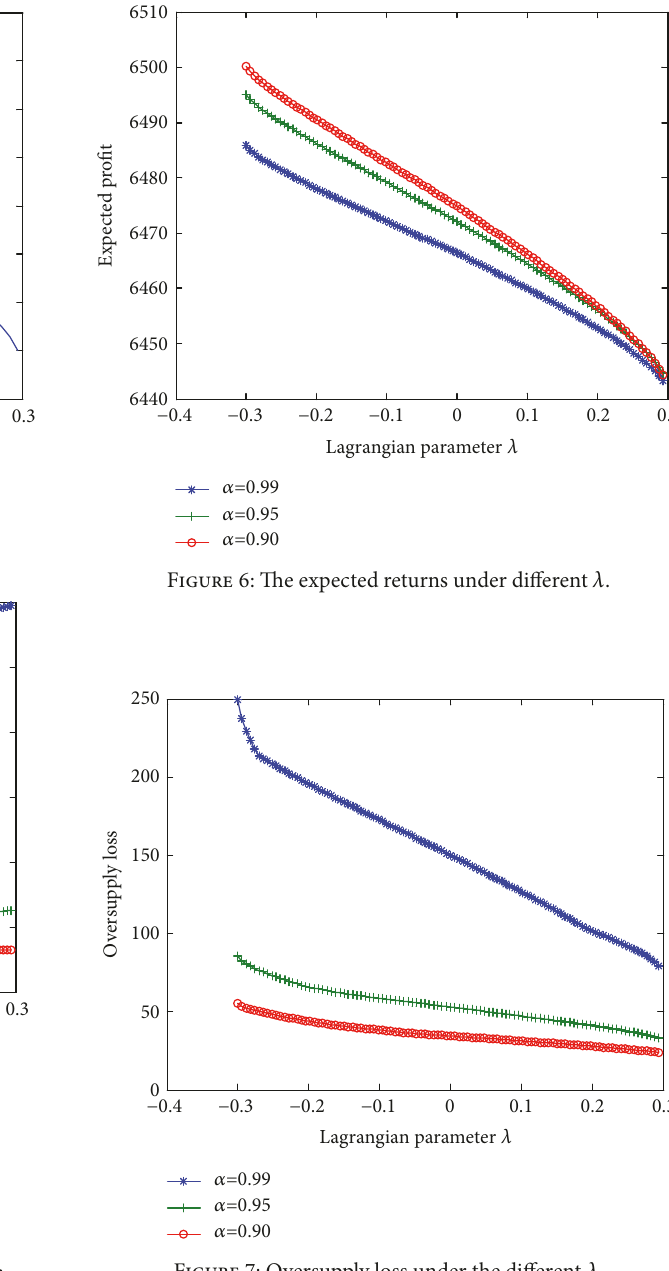
Figure 7: Oversupply loss under the different 𝜆